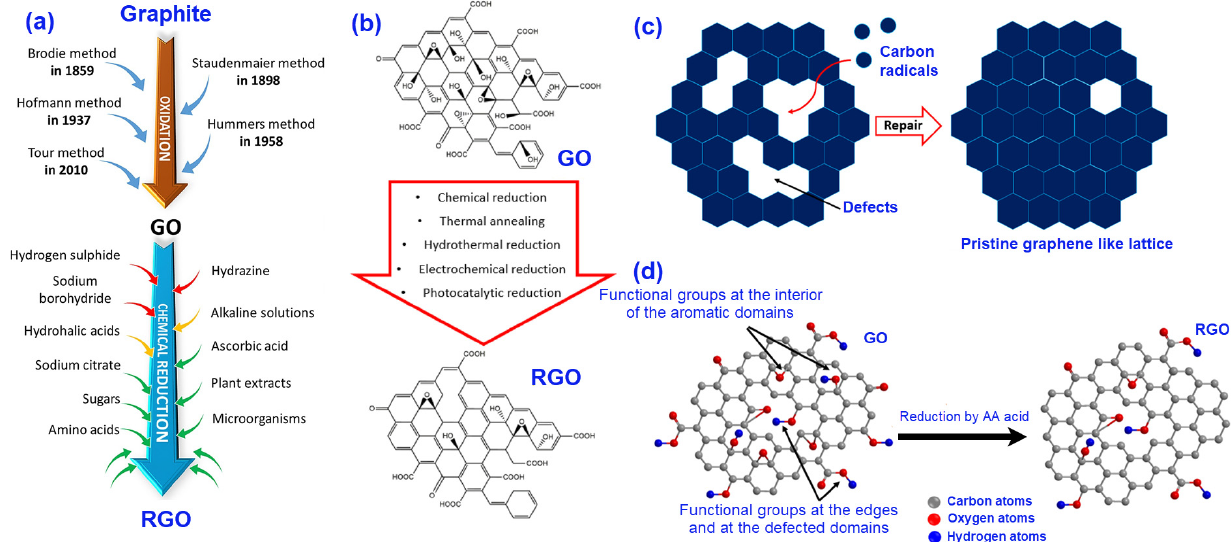
Figure 5. ( a ) Schematic diagram of fabricating RGO from graphite [97], ( b ) Steps followed for the conversion of GO into RGO [68], ( c ) Schematic diagram of repairing the defects of the pristine graphene [68], and ( d ) Changing of the oxygen functional groups after reduction using ascorbic acid [98]. All the figures were reprinted with permission.